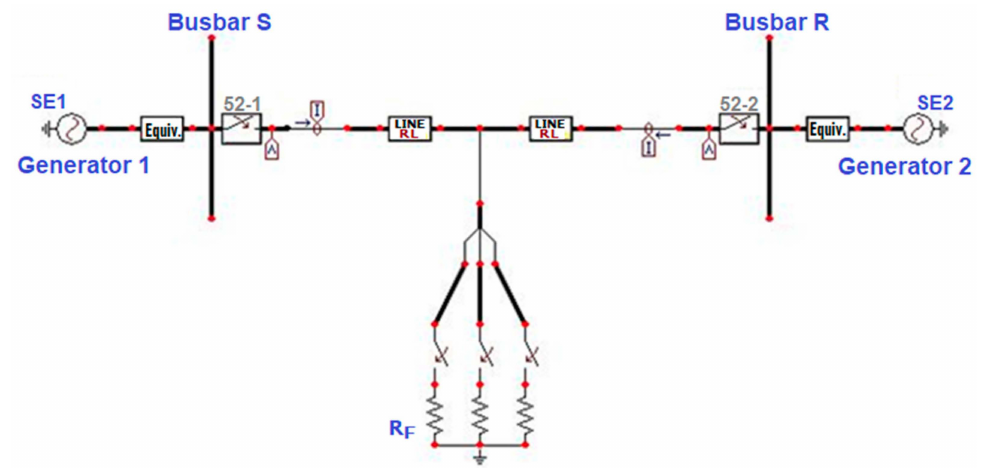
Figure 2. ATP model for short circuit simulation.